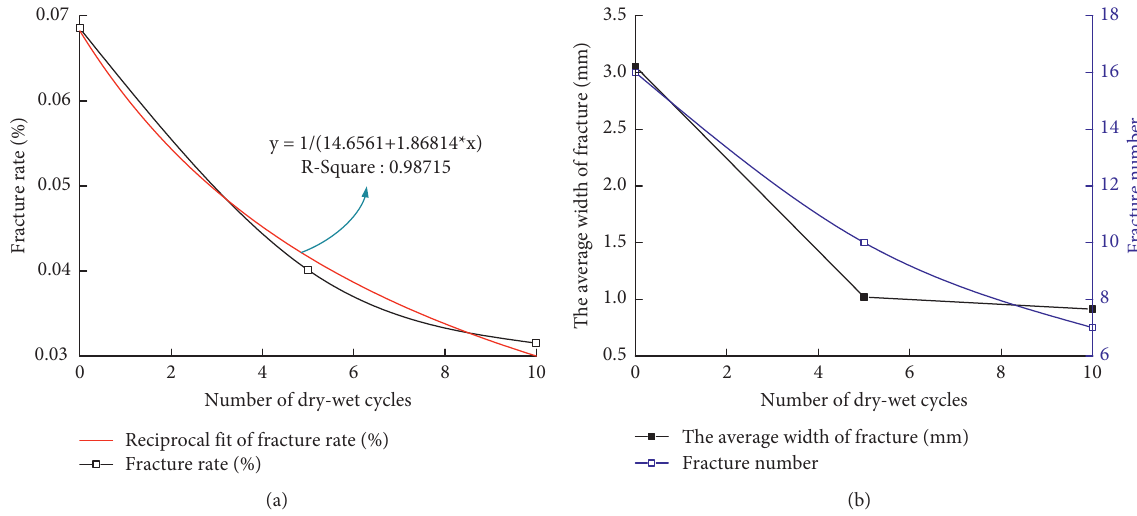
Figure 9: Change curves of the weakly cemented sandstone specimen fracture parameters with different numbers of dry-wet cycles. (a) Fracture rate. (b) Fracture width and number.